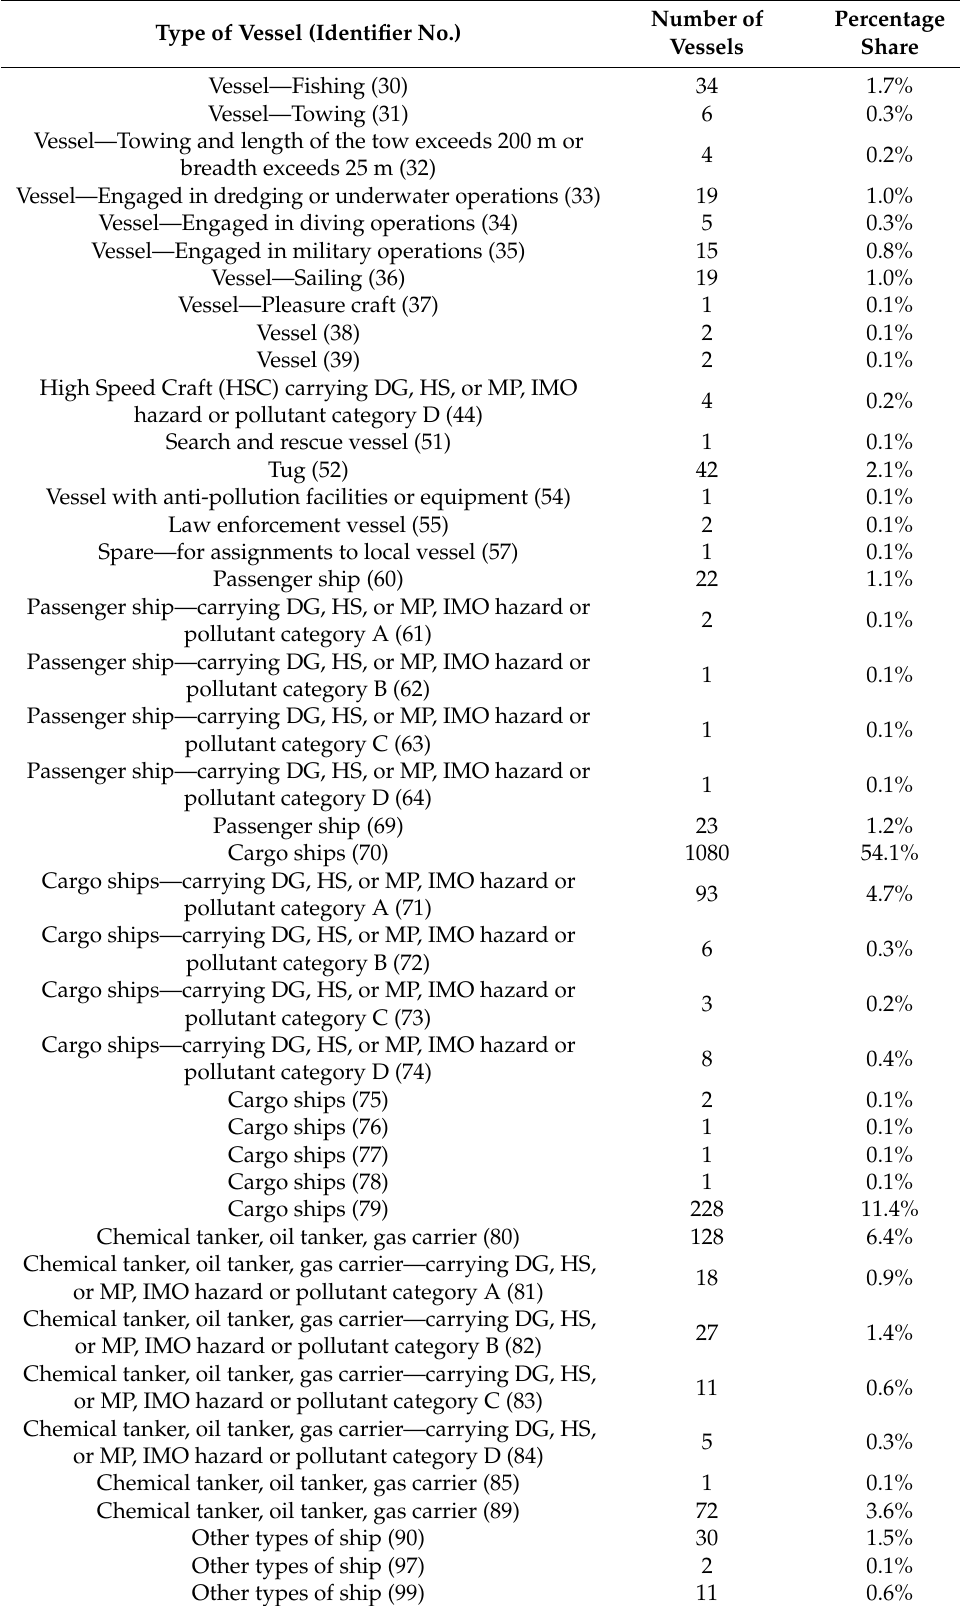
Table 13. List of vessels on the 3-3 measurement profile, broken down by